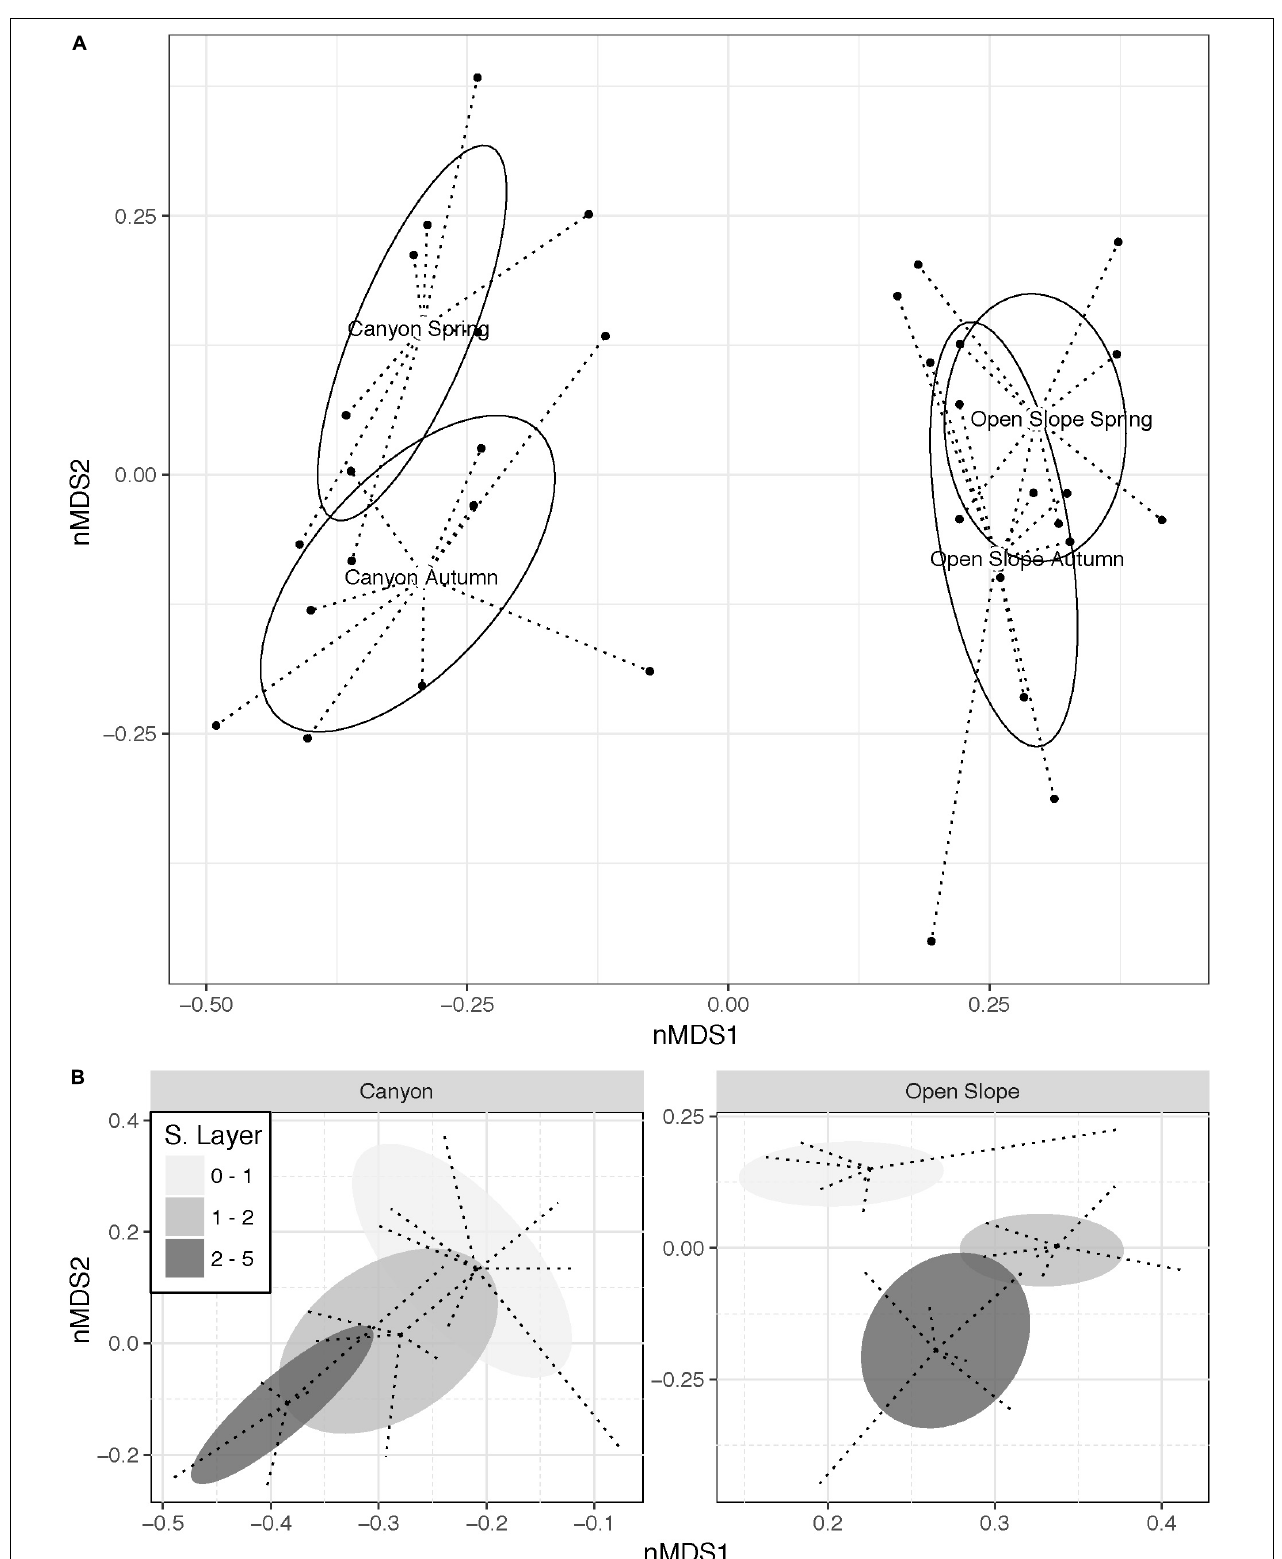
FIGURE 8 | Non-metric MDS plots (Bray–Curtis similarity) based on Hellinger transformed microbial community data (OTUs) illustrating the significant interactions: (A) Habitat × Season and (B) Habitat × Sediment Layer.